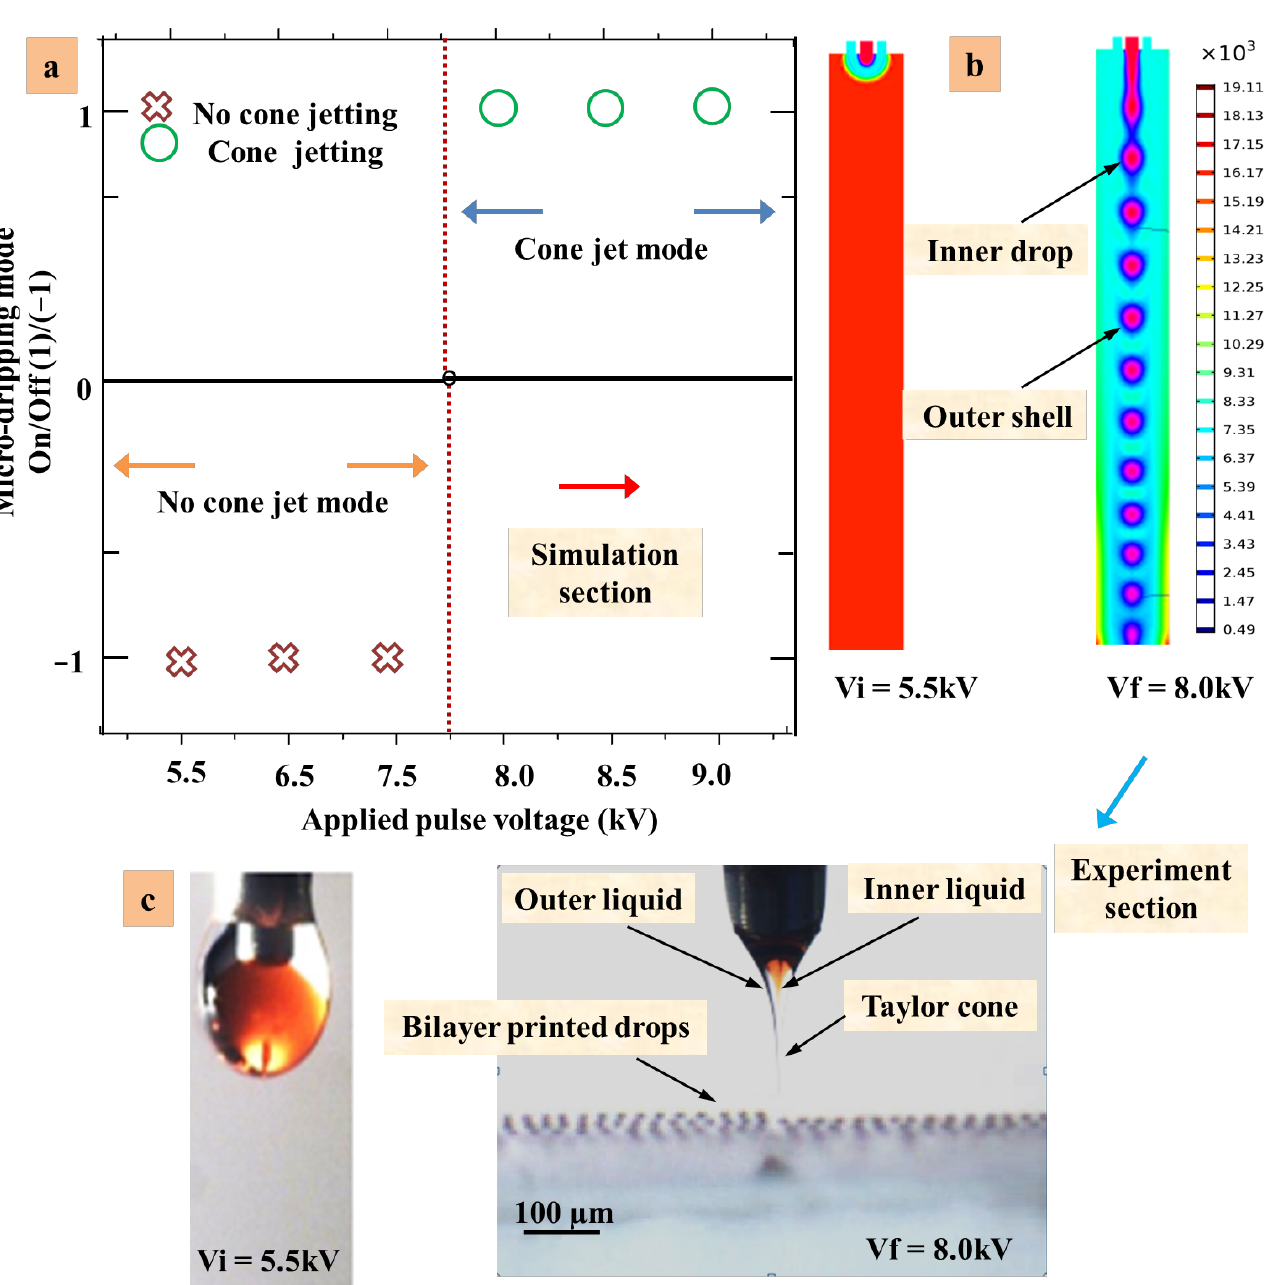
Figure 9. The contrast between simulation jetting and printing experimental jetting: ( a ) cone jetting status , ( b ) simulation results under dc pulse voltage , ( c ) the experimental results under identical parameters.